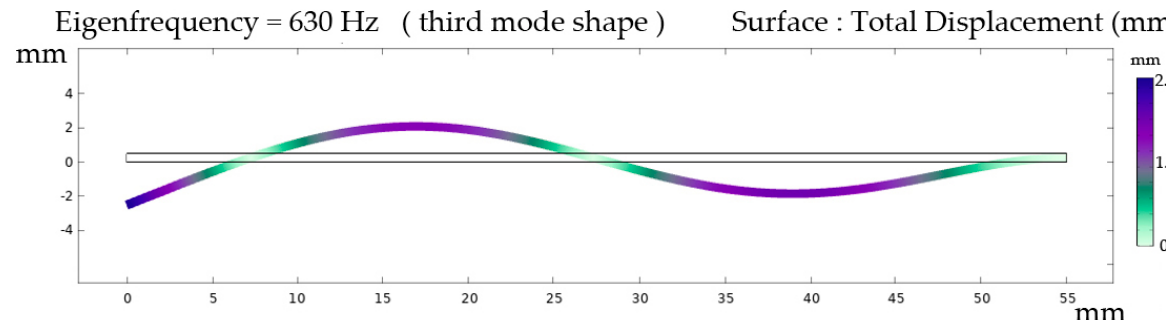
Figure 16. Third mode shape of piezoelectric beam III.